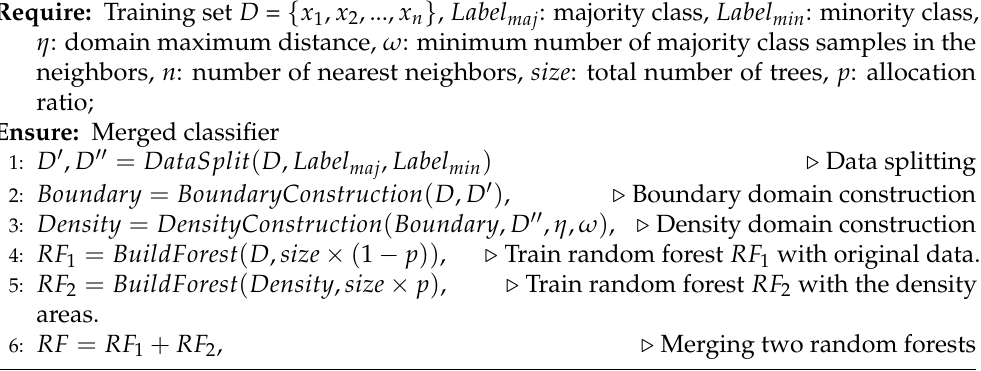
Algorithm 1 Density-based random forest (DBRF).